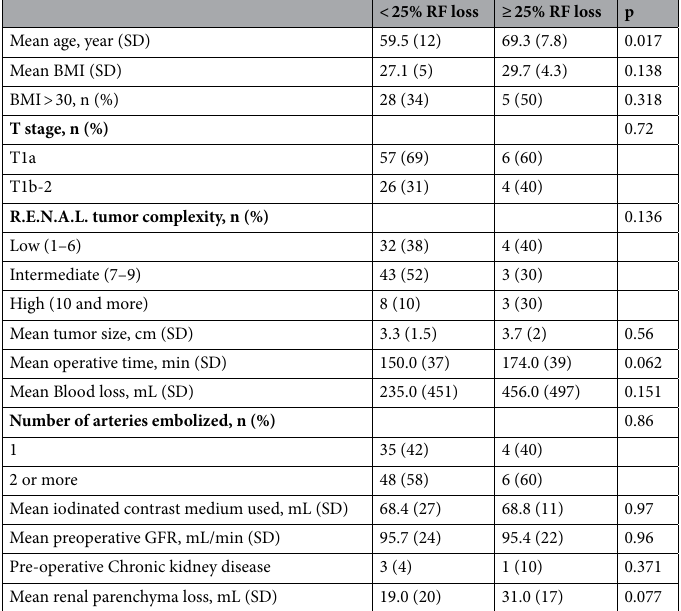
Table 3. Bivariate analysis of predictive factors of significant renal function decrease.